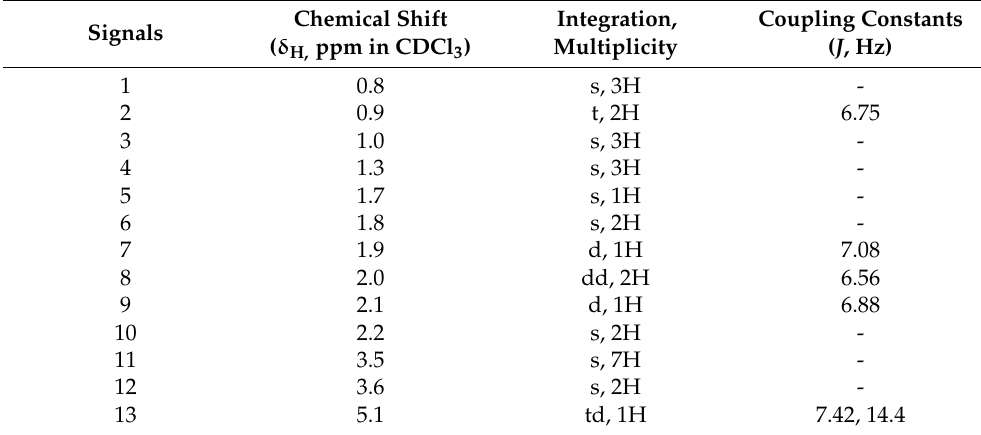
Table 8. 1 H-NMR spectral data of compound B isolated from the C. erythrophyllum leaf acetone extract.